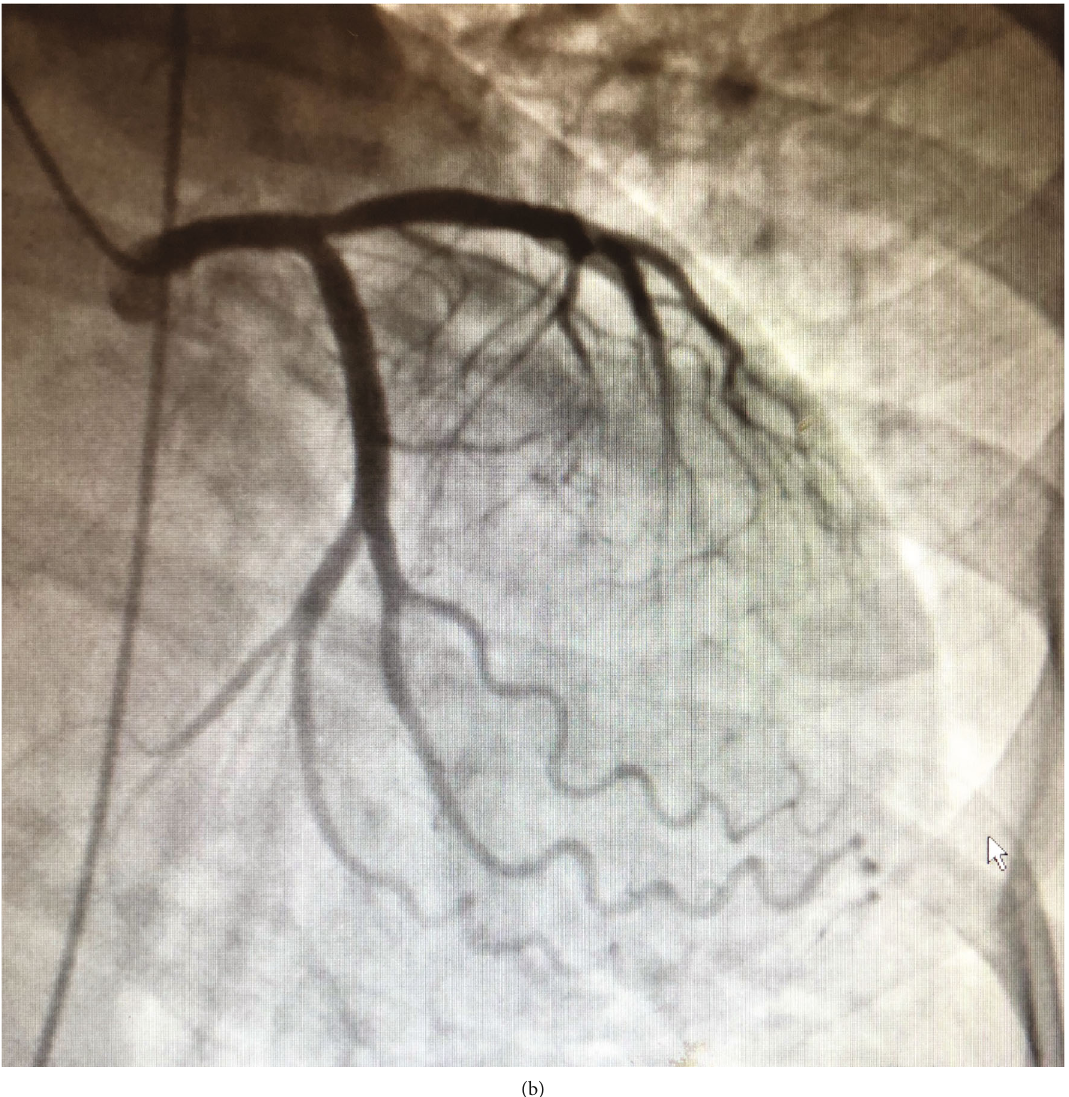
Figure 2: (a) The right coronary angiogram in the left anterior oblique cranial view showing the patent right coronary artery. (b) The left coronary angiogram in the right anterior oblique caudal view showing 50% lesion in the proximal left anterior descending artery, which is not consistent with the presentation as non-ST segment elevation acute coronary